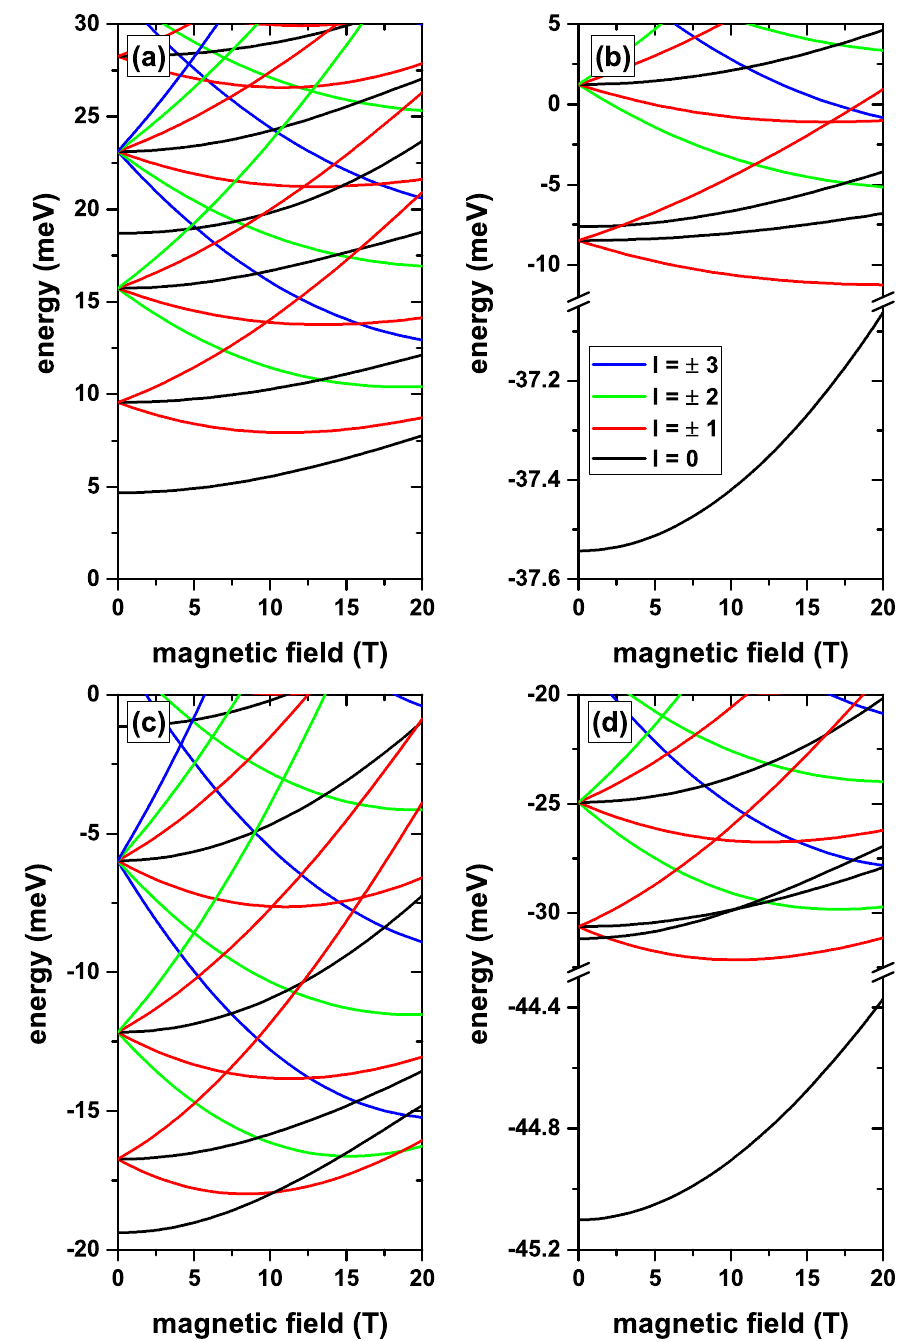
Figure 4. (color online) The lowest confined electron states in a CdS/ZnS spherical QD as functions of the MF. Results are without ( a , c ) and with ( b , d ) on-center donor impurity, with R 1 = 20nm and R 2 = 30nm, for several values of the l -quantum number. Calculations are with no EF in ( a , b ), whereas in ( c , d ) the results are for a central EF F = −